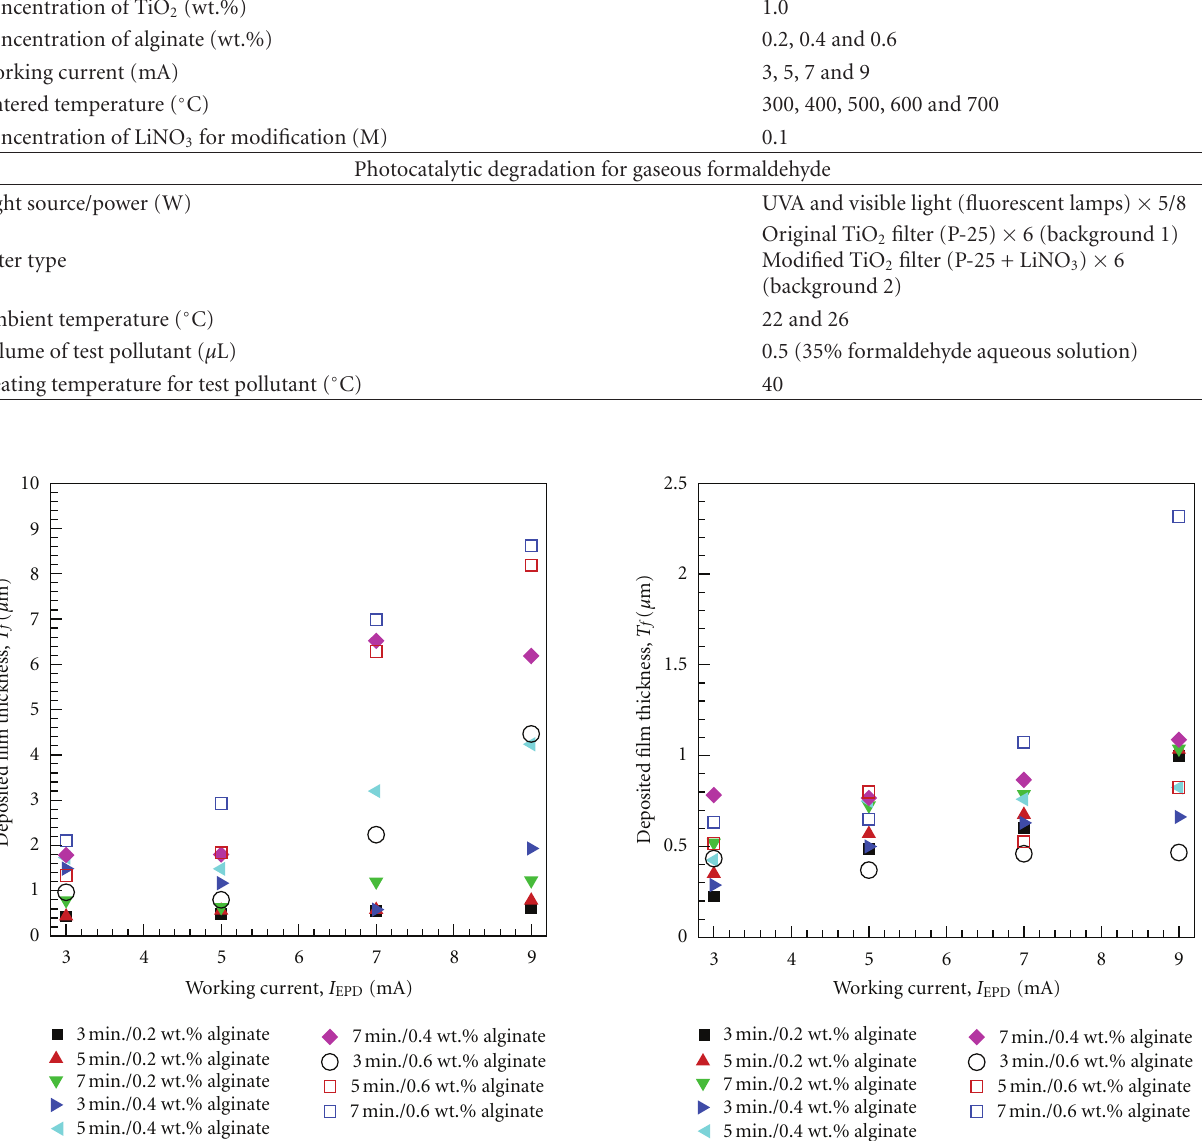
Figure 6: Deposited film thickness on side A varies with the work- ing currents dispersant for di ff erent concentration and durations.